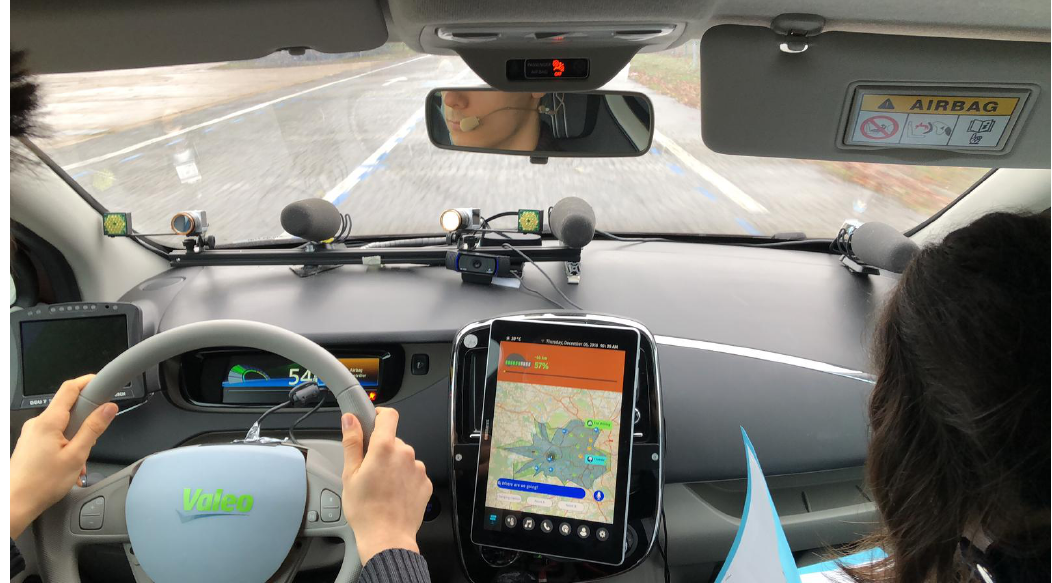
Figure 5. Test vehicle and adaptive HMI on mounted tablet